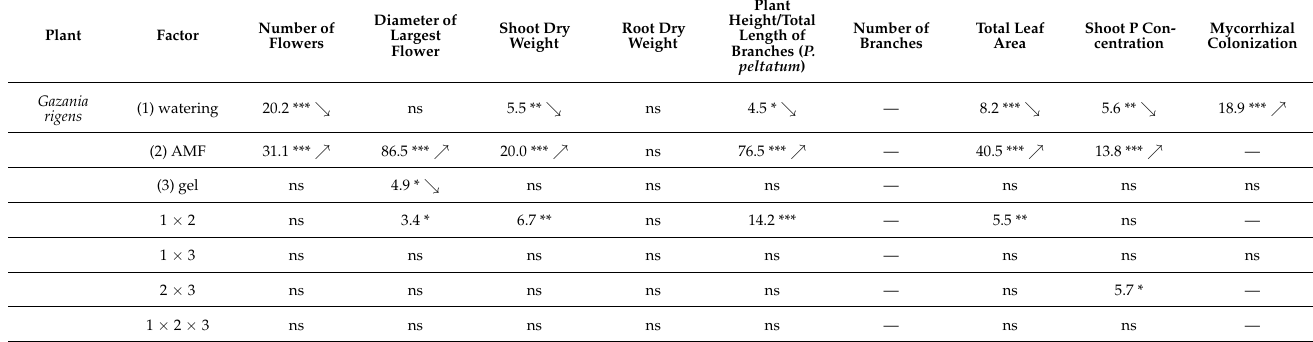
Table 3. Effects of factors (1—watering, 2—arbuscular mycorrhizal fungi (AMF) inoculation, 3—hydrogel) and their interactions on various growth parameters and mycorrhizal colonization of roots of model plants according to three-way ANOVA (presented as F value and significance) or according to generalized linear model for number of branches (presented as Wald statistics